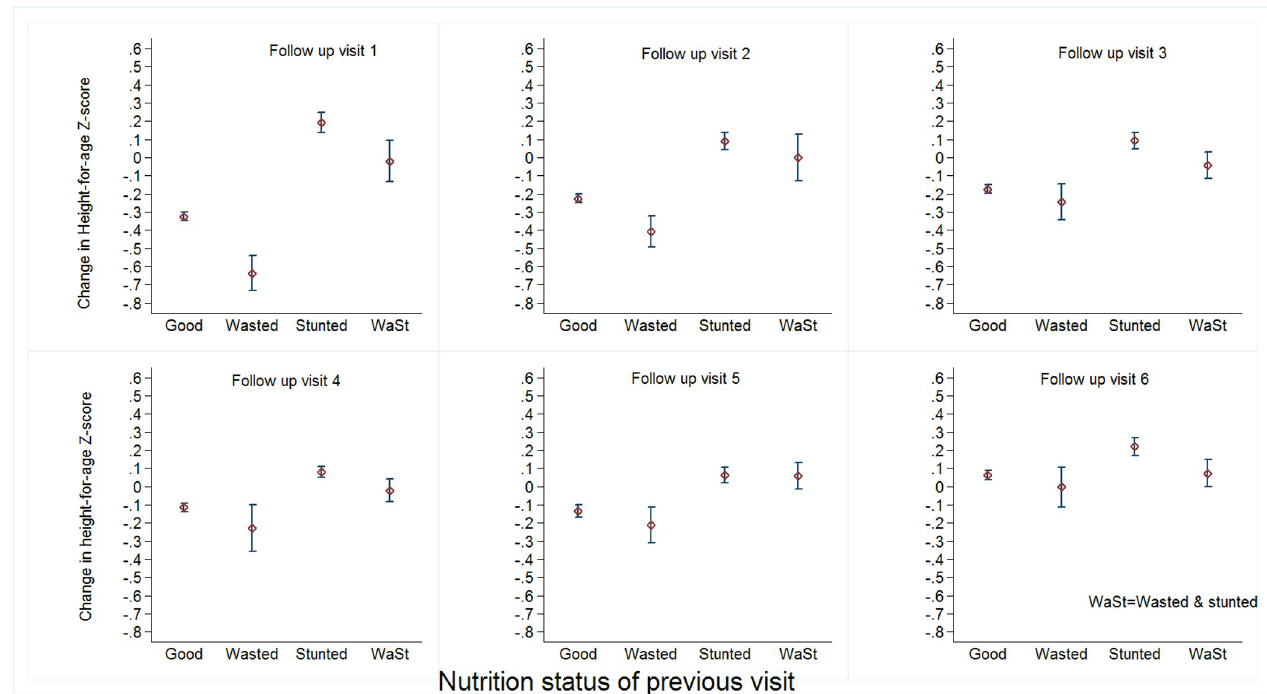
Fig 1. Linear growth velocity for non-wasted/non-stunted, only wasted, only stunted and wasted and stunted children at the different follow-up visits.